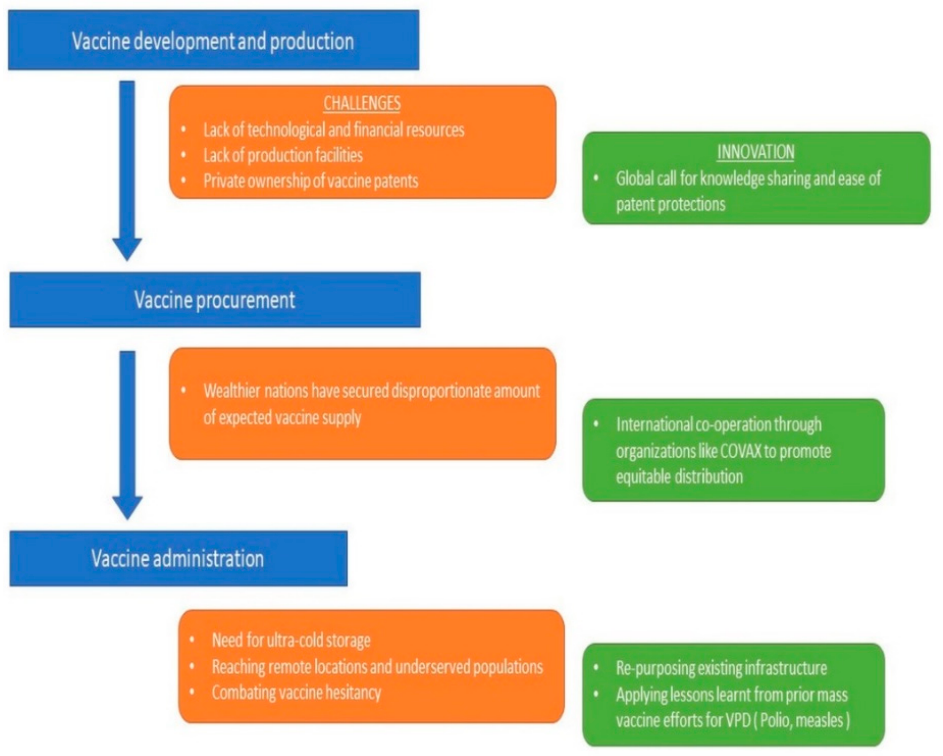
Figure 1. Vaccination as a public health strategy in developing nations: facing challenges with innovations and existing community strengths.